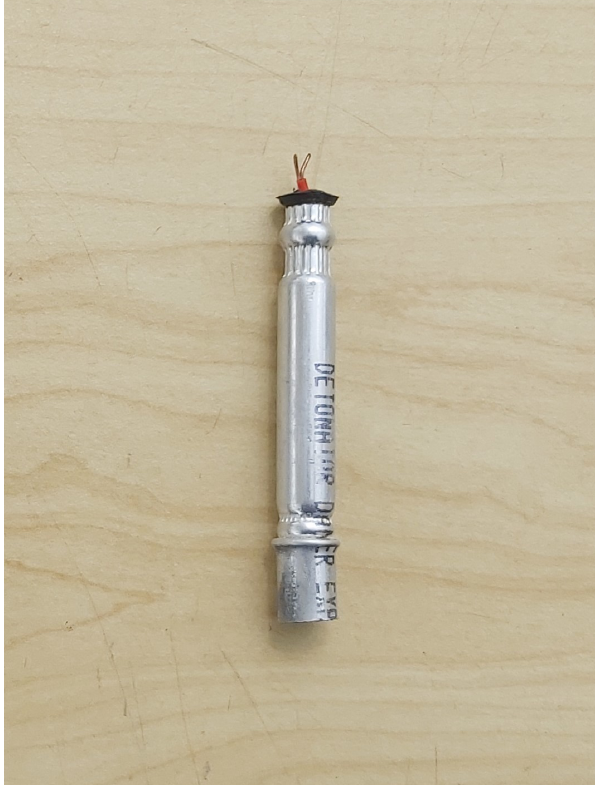
Figure 10. Electric IED detonators commonly used in Colombia. The approximate dimension is 54 mm, with a diameter of 4